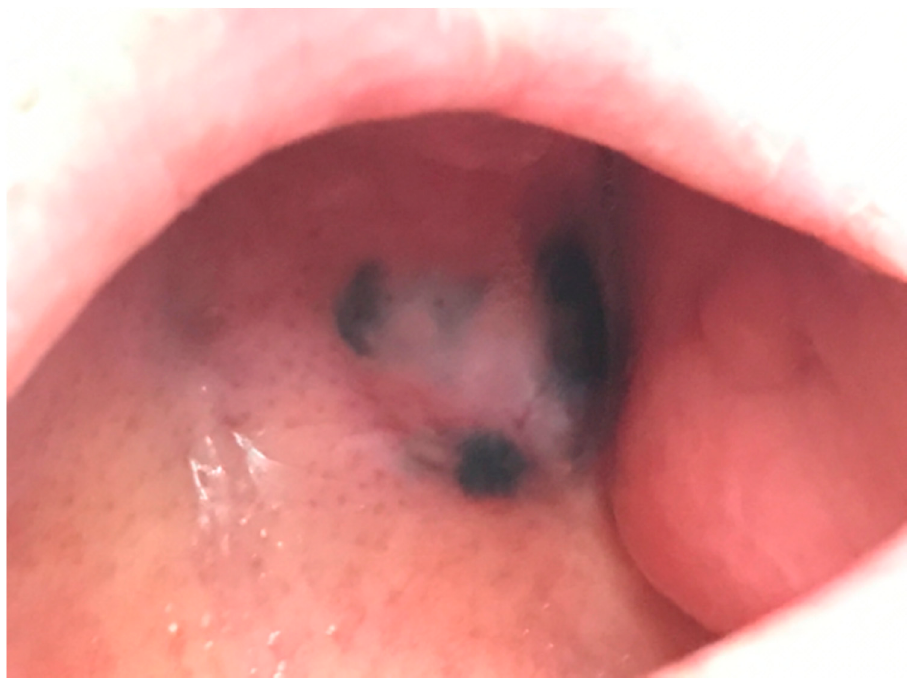
Figure 5. Oral melanoma: clinical presentation showing a black nodule with depigmented areas. For the correct management of oral pigmentations, focal lesions appearing in adults with a diameter greater than 0.5 cm and without known triggering factors or changing at follow-up should be biopsied. Nodules should be promptly excised without any monitor- ing